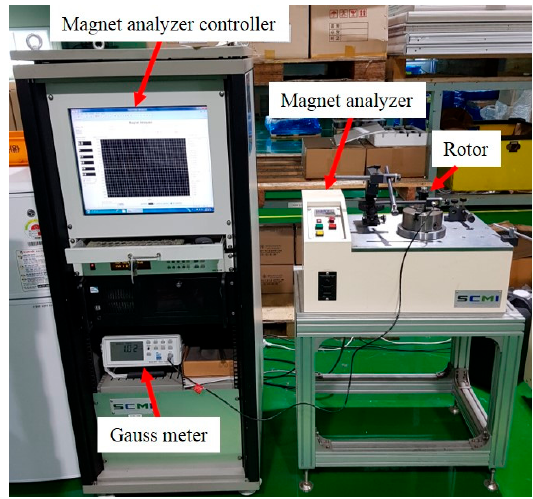
Figure 8. Experimental test set up of a gauss meter.